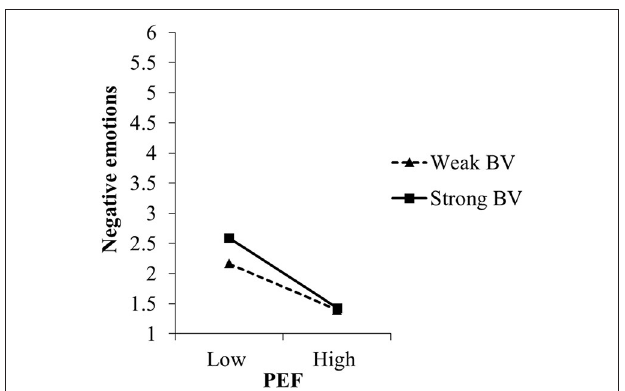
FIGURE 7 | Moderating effect of biospheric values (BV) on the relation between perceived environmental friendliness (PEF) of and negative emotions toward algae-based biofuel in study 2. For the simple slope analyses, we used the estimates of step 2 of the regression analyses (c.f. Table 7 ).